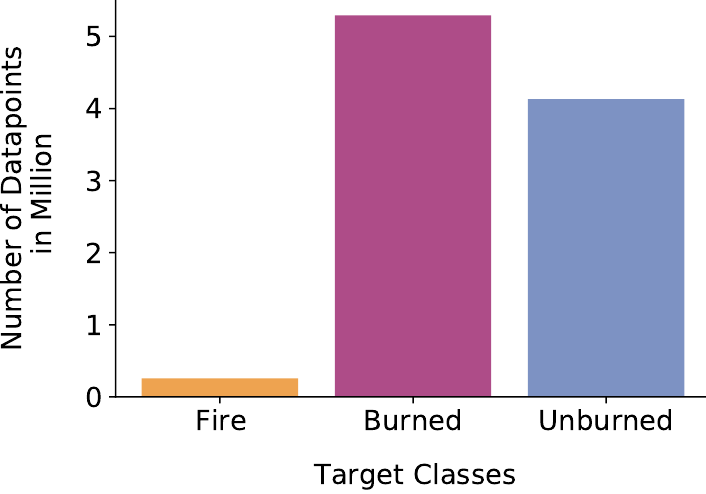
Figure 4. Distribution of data points of the whole dataset combined from all study regions per target class.